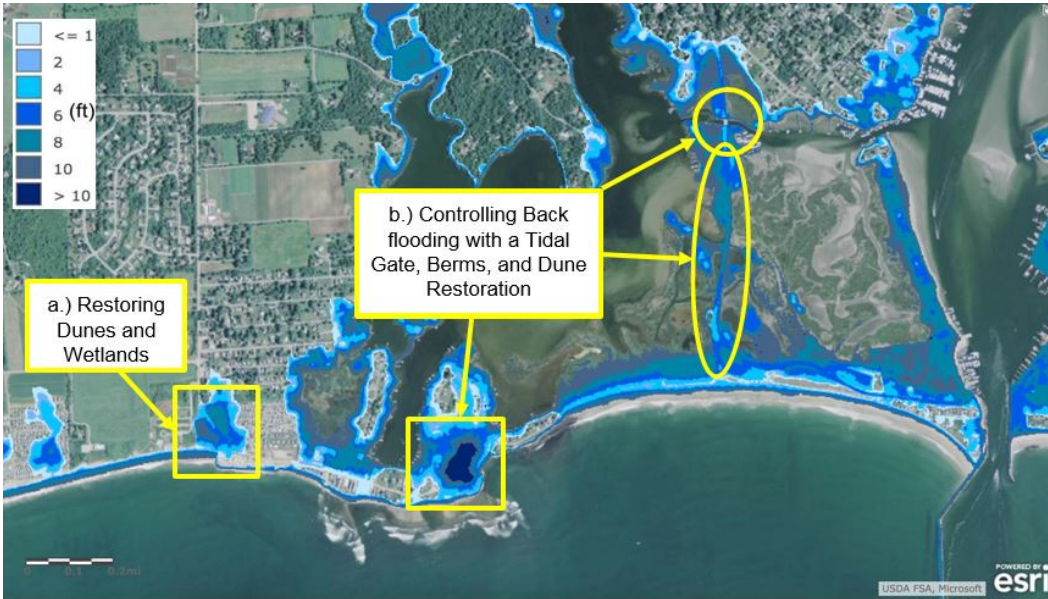
Figure 16. Two adaptation measures proposed and analyzed for the study area.